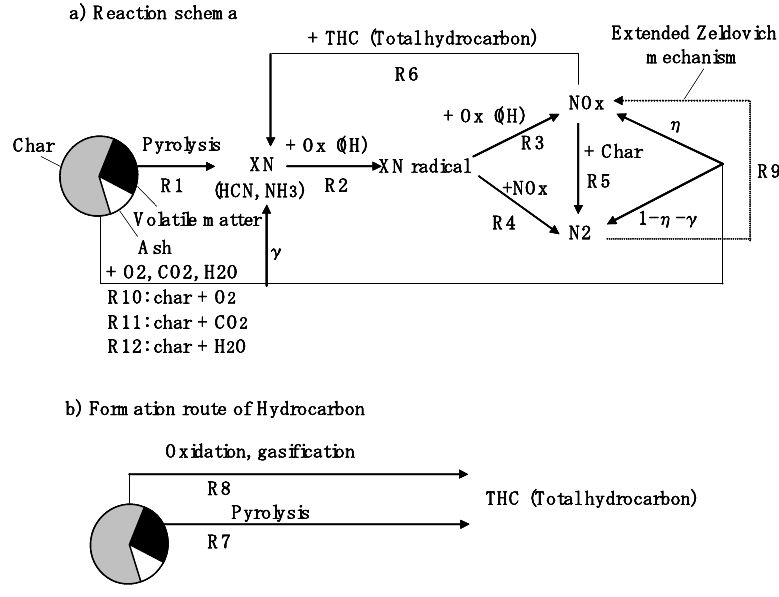
formation and reduction. x